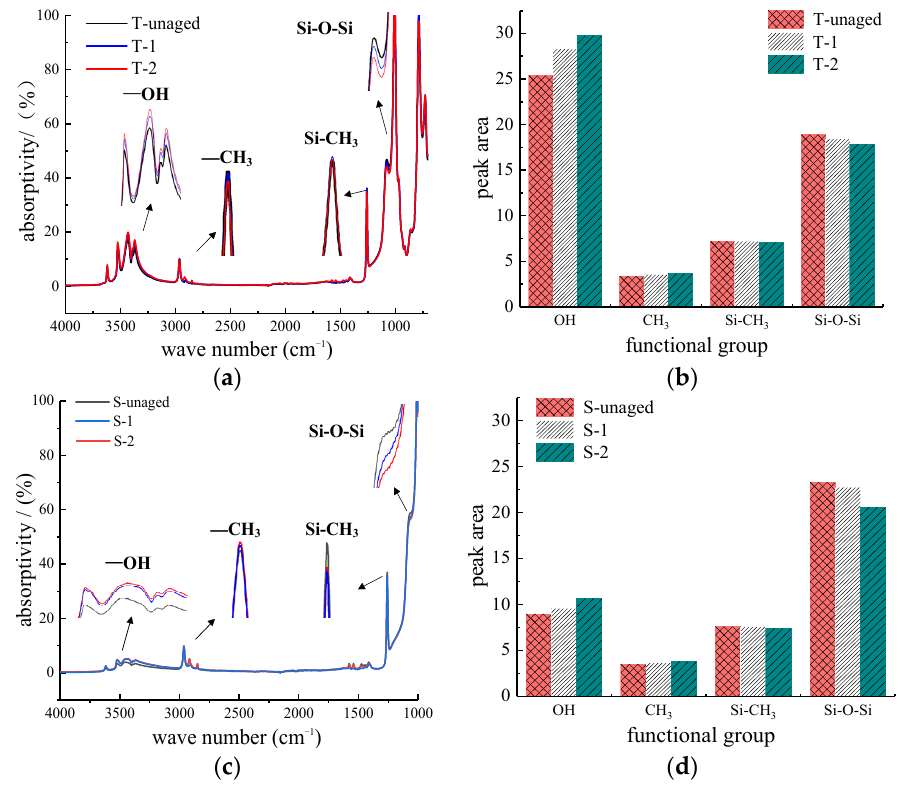
Figure 9. FTIR spectra of T-shaped and square-shaped composite cross-arm silicone rubber sheaths and absorption peak areas of main functional groups: ( a ) T-type FTIR spectrum; ( b ) T-type functional group absorption peak area; ( c ) Square FTIR spectrum; ( d ) Square functional group absorption peak area.